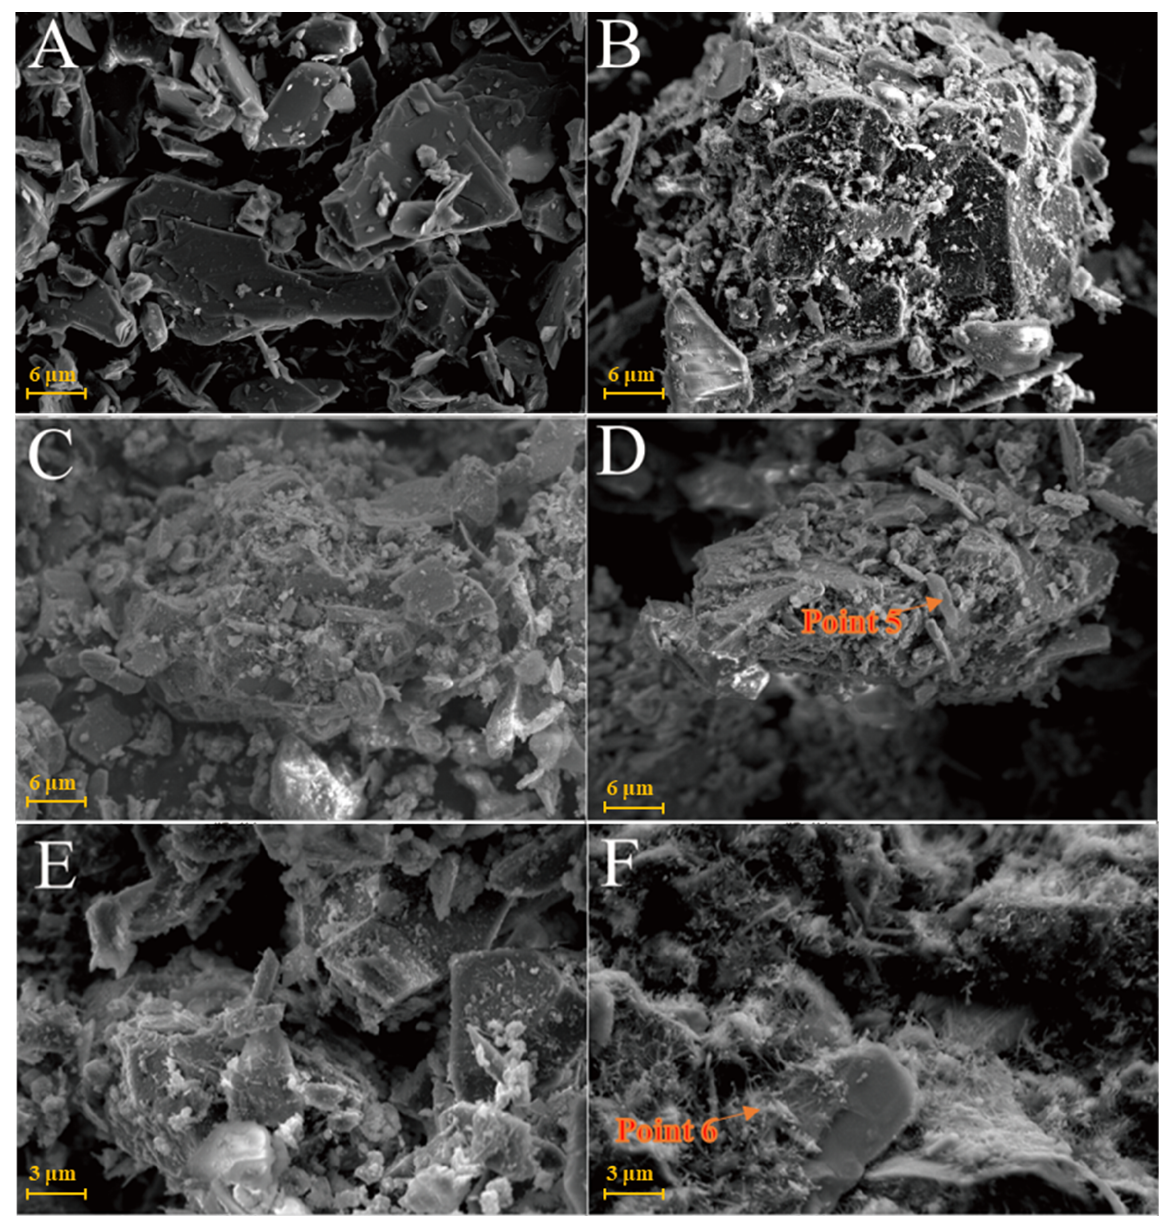
Figure 9. SEM images of illite samples: ( A )—illite raw material; ( B )—Y0 samples cured for 3 days; ( C )—Y0 samples cured for 7 days; ( D )—samples of Y0 cured for 28 days; ( E )—Y0-2 samples cured for 3 days; ( F )—Y0-2 samples cured for 3 days.